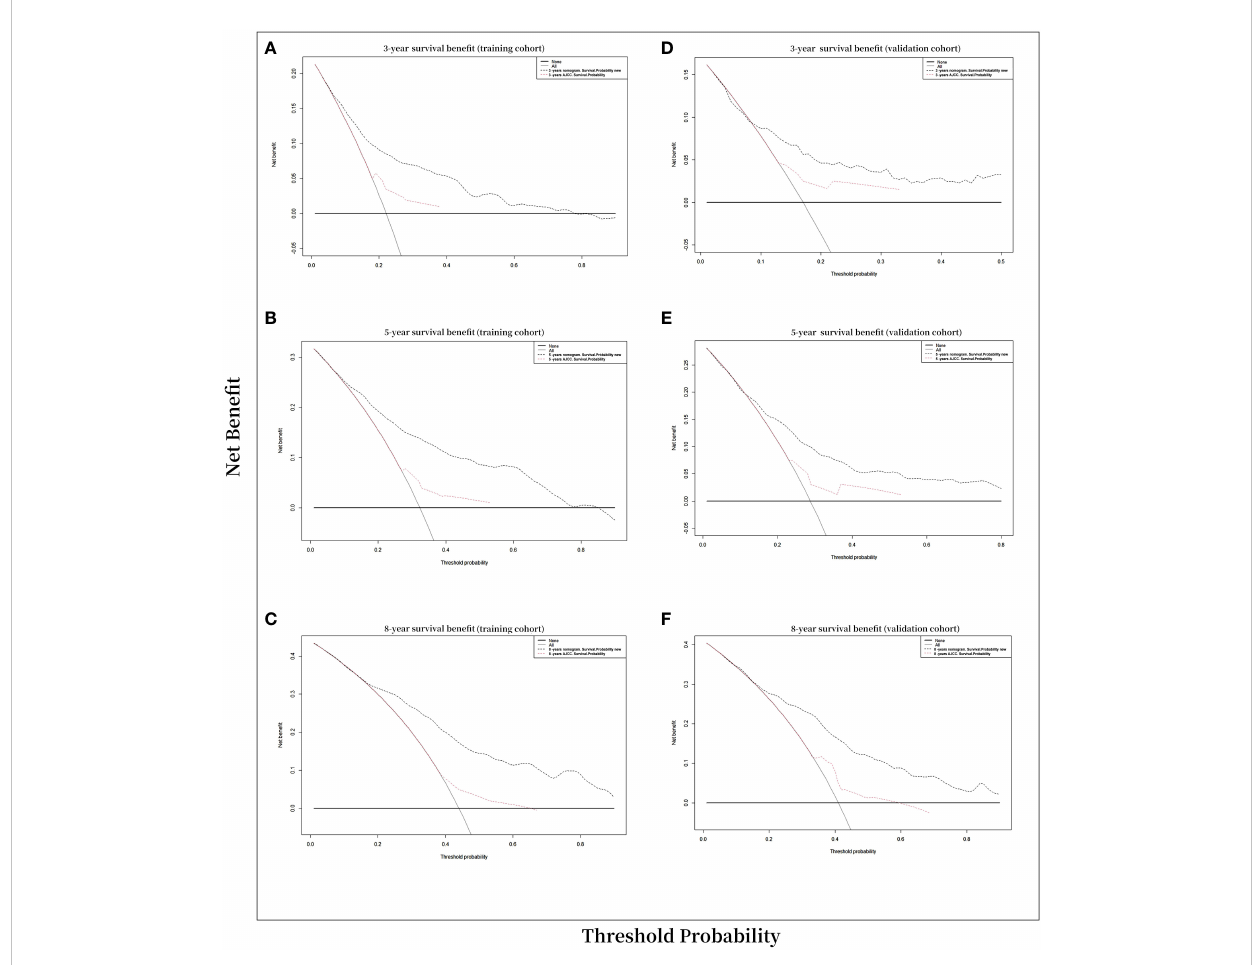
FIGURE 5 Decision curve analysis curves. Decision curve analysis of the nomogram for prediction of 3-, 5-, and 8-years overall survival probability with CVC patients. (A) 3-year survival bene fi t in the training cohort. (B) 5-year survival bene fi t in the training cohort. (C) 8-year survival bene fi t in the training cohort. (D) 3-year survival bene fi t in the validation cohort. (E) 5-year survival bene fi ts in the validation cohort. (F) 8-year survival bene fi t in the validation